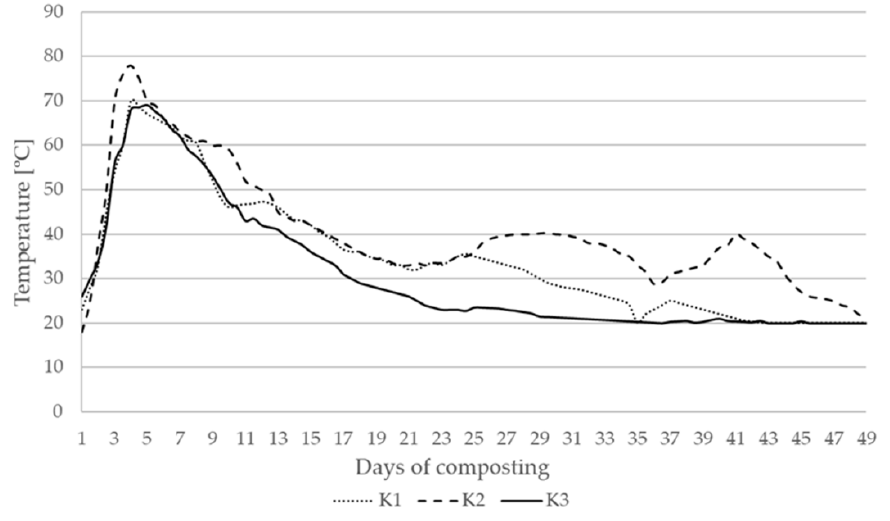
Figure 4. Temperature changes in analyzed composts.